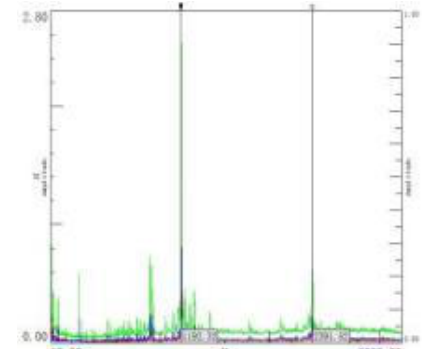
Figure5 Body vibration frequency of turbine shaft helicopter (main rotor 800 r/ min)